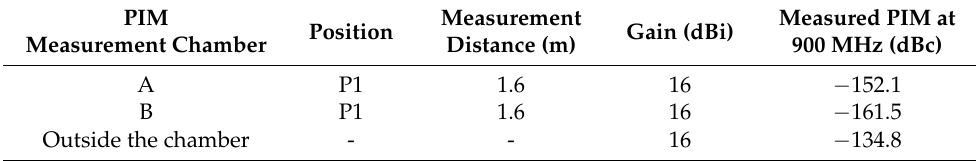
Table 5. Measured results of a high-gain antenna in two chambers. PIM Measurement Position Measurement Chamber Distance